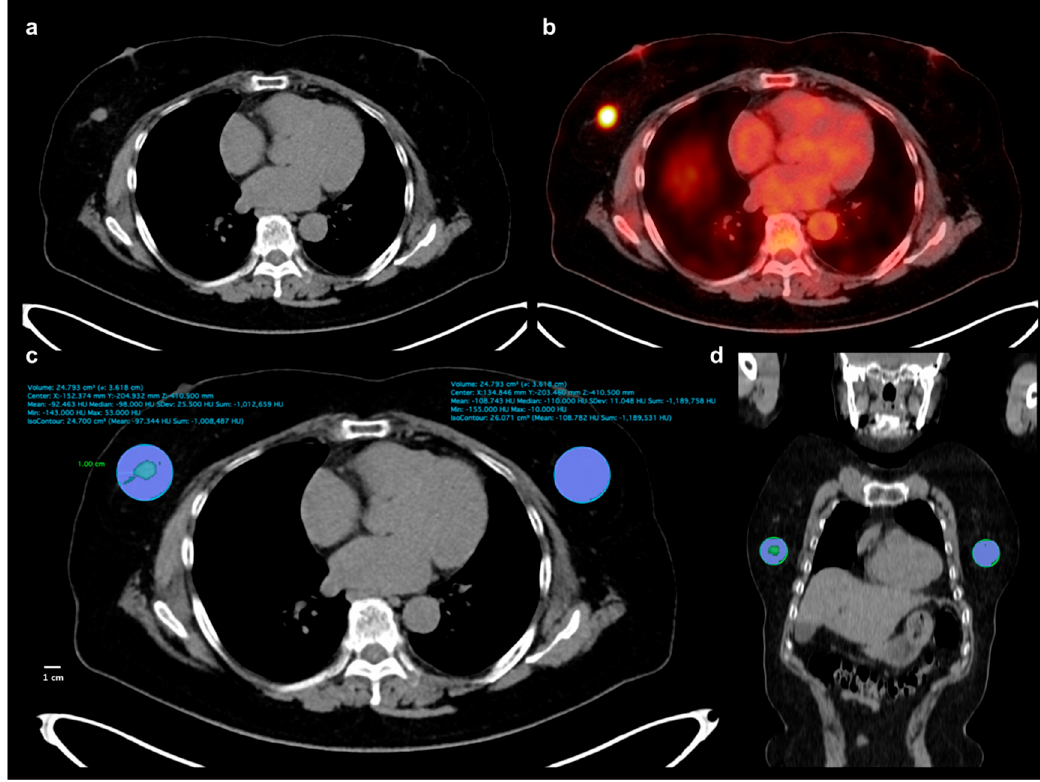
Figure 4. Measurement example of CT-attenuation of tumor-adjacent breast adipose tissue and contralateral breast adipose tissue. A 62-year-old woman underwent FDG PET/CT for staging work-up of right breast cancer, histopathologically confirmed as invasive ductal carcinoma. A mass lesion with intensely increased FDG uptake is observed in outer aspect of right breast, ( a , b ), showing maximum SUV of 8.44. A spheroid-shaped volume-of-interest that includes peritumoral breast tissue within a 1-cm distance from the tumor margin was manually drawn over the ipsilateral breast tissue, ( c , d ). Another spheroid-shaped volume-of-interest of the same size was drawn over the contralateral breast tissue in the same quadrant of the breast, (c,d). Within the volume-of-interests drawn in bilateral breast tissues, the area of breast adipose tissue defined as an area with CT-attenuation range between − 200 and − 50 HU was automatically delineated. Mean CT-attenuation value of breast adipose tissue was measured for each VOI (c): − 92.463 HU for tumor-adjacent breast adipose tissue and − 108.743 for contralateral breast adipose tissue.